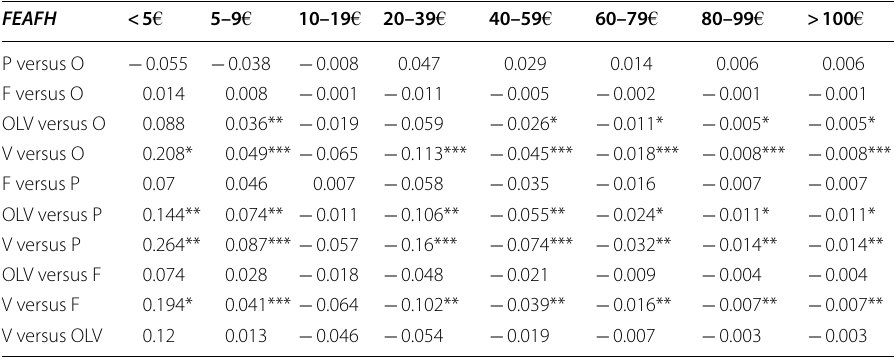
Statistical significance levels of 10, 5, and 1% are denoted as *, **, and ***, respectively Due to space constraints, the marginal effects of the covariates are available from the authors upon request